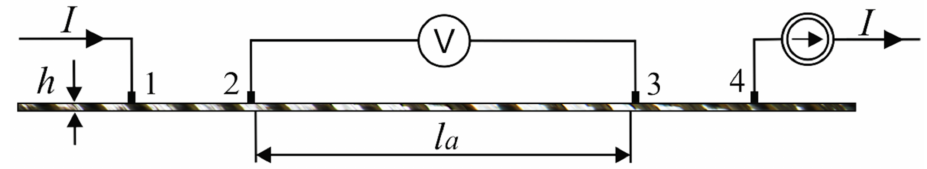
Figure 2. Strip resistance measurements (the side